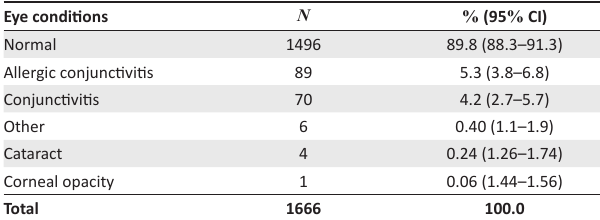
TABLE 3: Distribution of normal and external eye disease by percentage and confidence